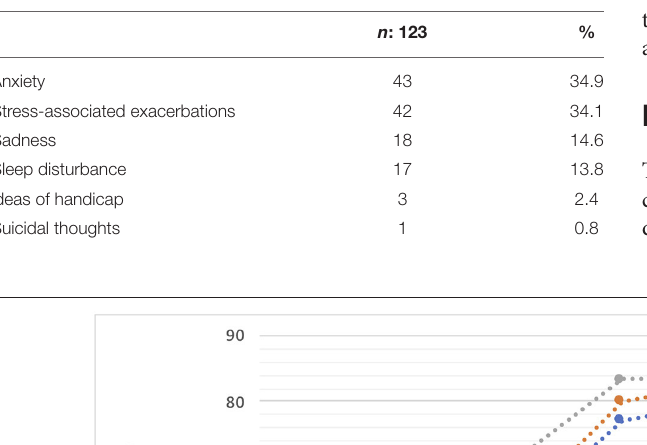
Frontiers in Allergy |